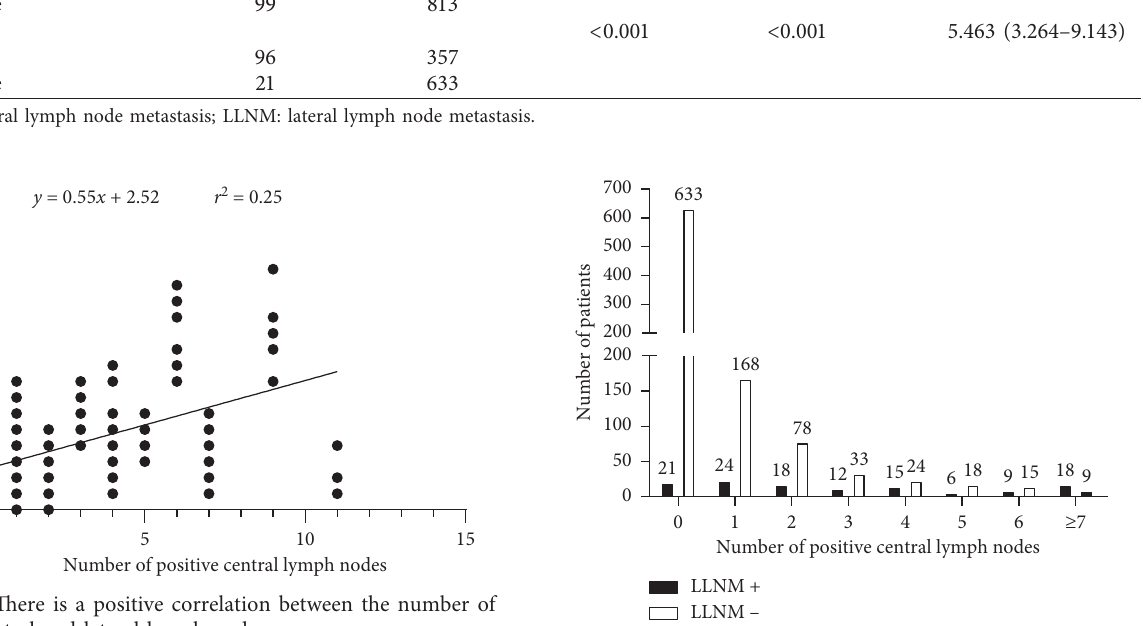
Figure 2: The incidence of lateral lymph node metastasis increased with the number of positive central lymph nodes. LLNM, lateral lymph node